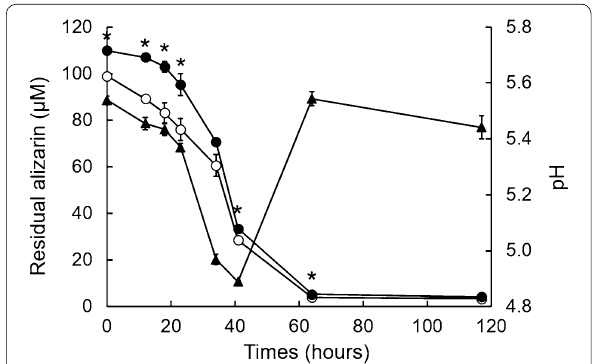
Fig. 5 Effect of pH on alizarin degradation by DyP. Time courses of alizarin concentration and pH values in liquid cultures inoculated with 100 μM alizarin. Open and closed circles are residual alizarin concentrations at pH 3.2 (optimum pH for DyP activity) and at unadjusted pH, respectively. Closed triangles denote the time course of pH values. Data are presented as mean SD (n 3; ± = unpaired two-tailed t